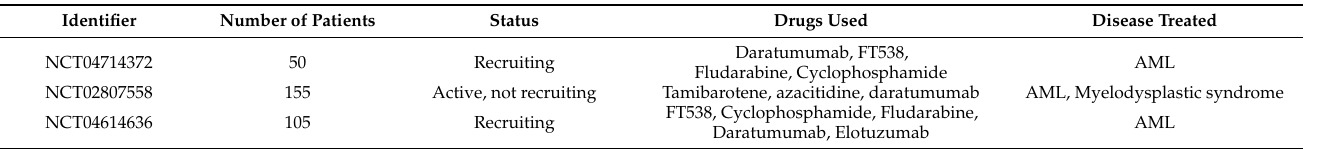
Table 6. Daratumumab and Isatuximab (in combination with other chemotherapeutics) in Acute Myeloblastic